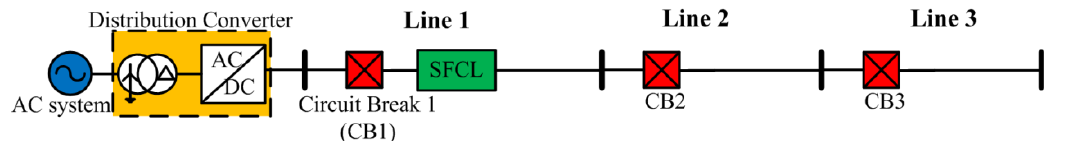
Figure 12. The structure of the DC distribution, including the SFCL.